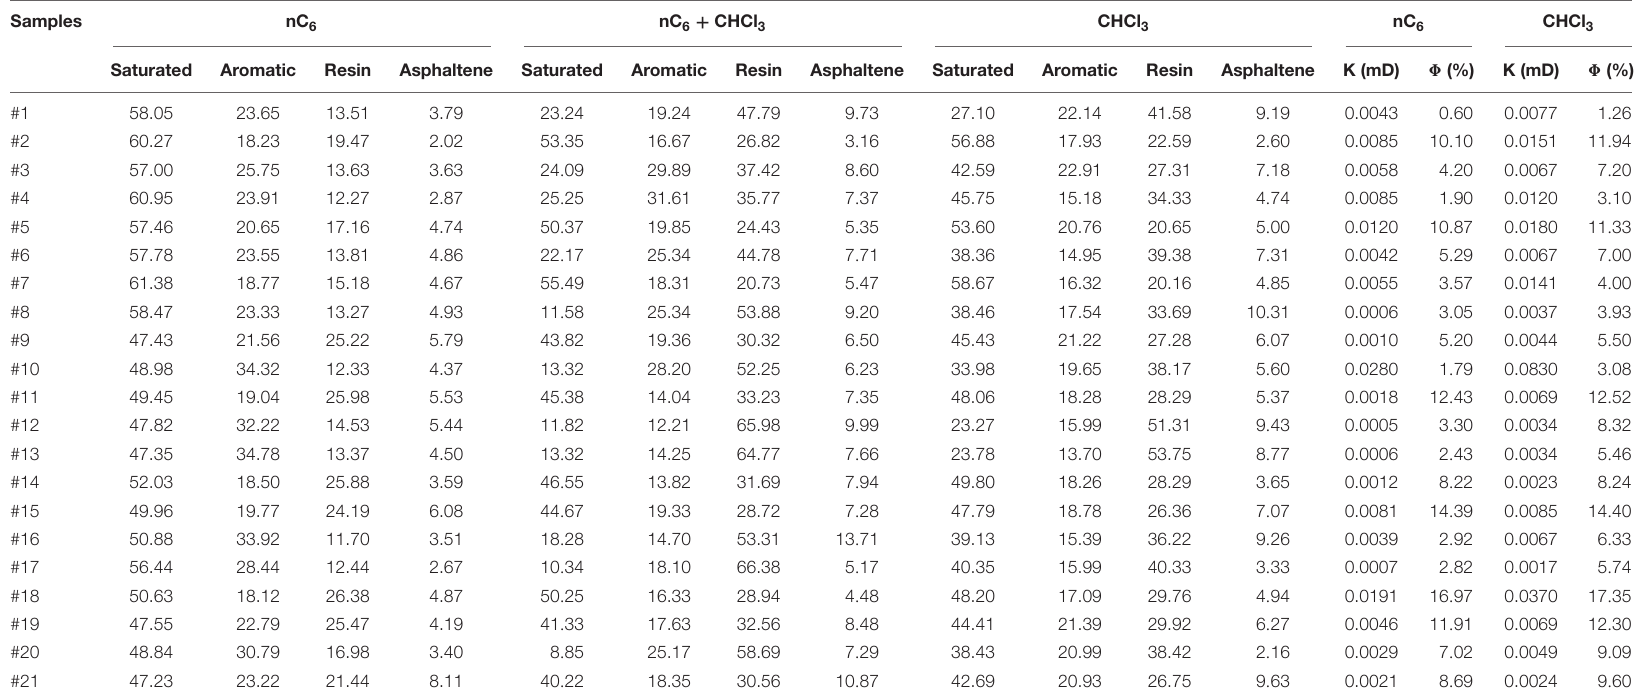
TABLE A2 | Analysis results of the extracts after different extraction treatments.